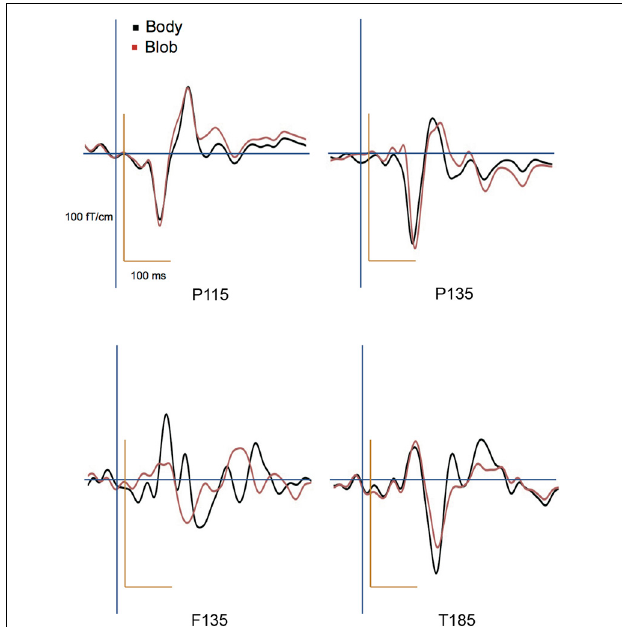
FIGURE 3 | Across-subjects averaged ERF waveforms in the right occipital, occipito-temporal, and front-temporal channels for “body” and “blob” responses (body, black line; blob, red line).